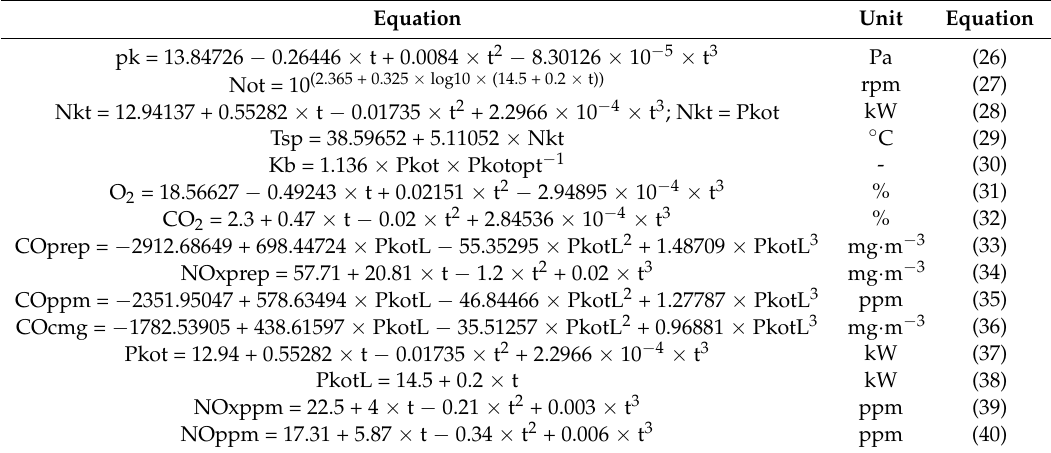
Table 3. Working times of parameters for boilers of 23 kW depending on operation time Tprov (Figure 8).